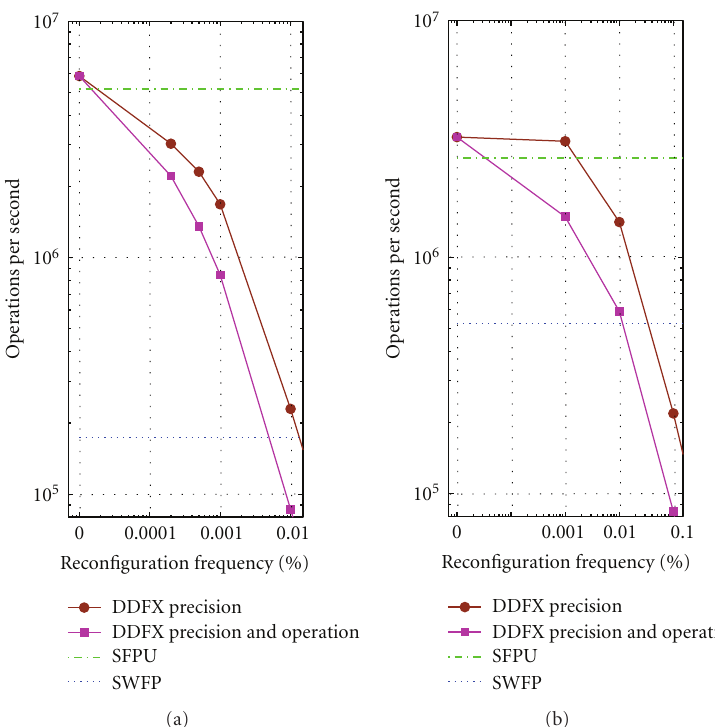
Figure 9: Performance results for a single DDFX core versus reconfiguration frequency for Virtex II Pro MicroBlaze (a) and Virtex 4 PowerPC405 (b). Here, 0% can not be represented in our logarithmic scale, thus it was included as the leftmost point in the graph. These measurements were taken using running hardware systems described in Section